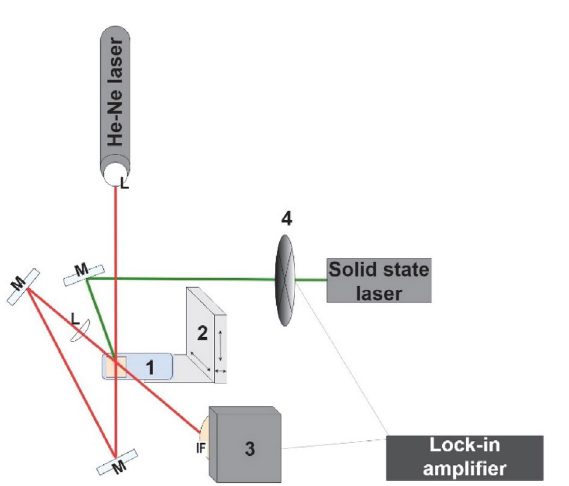
Figure 3. Experimental setup of BDS system.